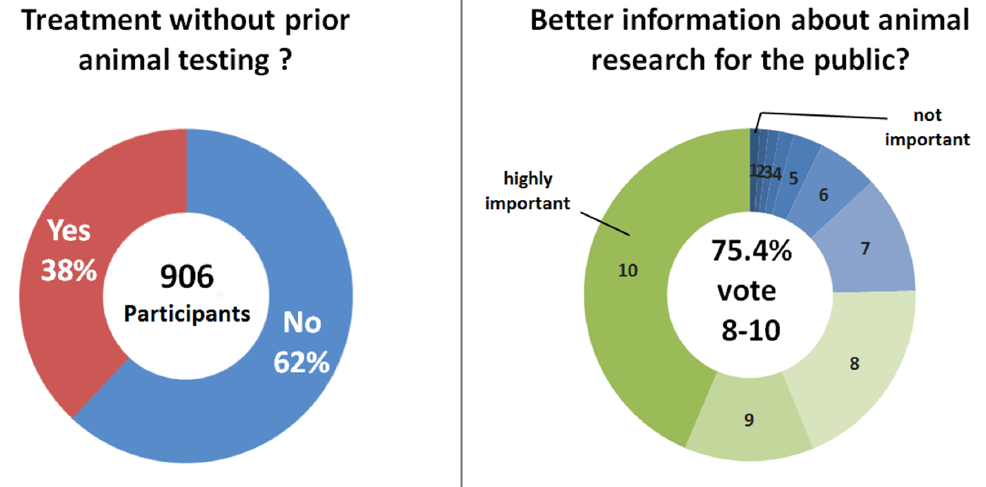
Figure 1. Survey results. Left: A majority of participants would not accept a treatment that has not been previously tested in animal models. Right: The need for better information about animal research for the public was rated high by 75% of the